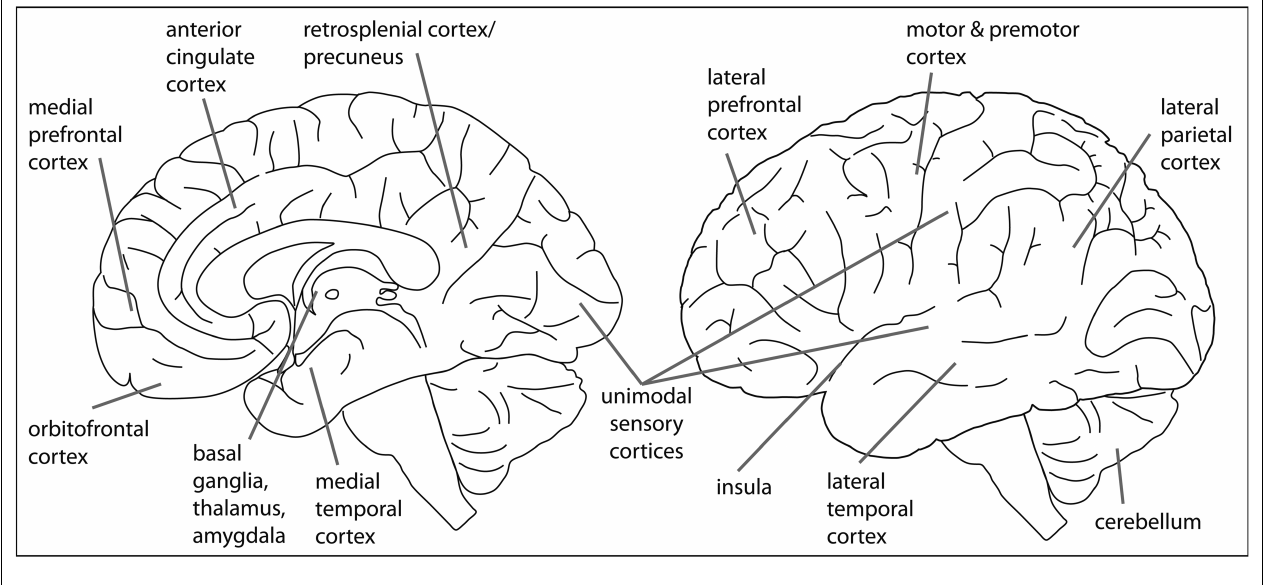
FIGURE 4 | The predictive brain. Numerous brain areas and networks have previously been associated with some aspect of prediction, thus illustrating the notion of the “predictive brain”. It is important to note that this outline is